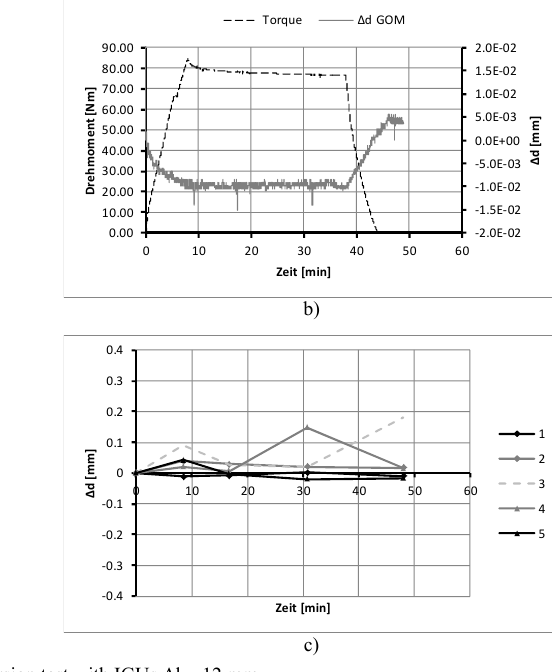
Fig. 21 Test results of the torsion test with IGUs Δ l = 12 mm a) geometry and position of measuring point